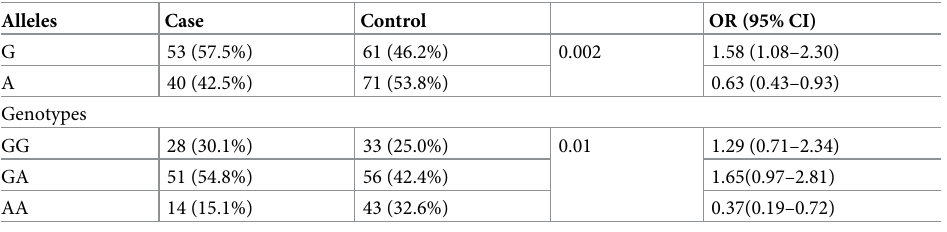
Table 4. Genotype distribution and allele frequencies of BDNF